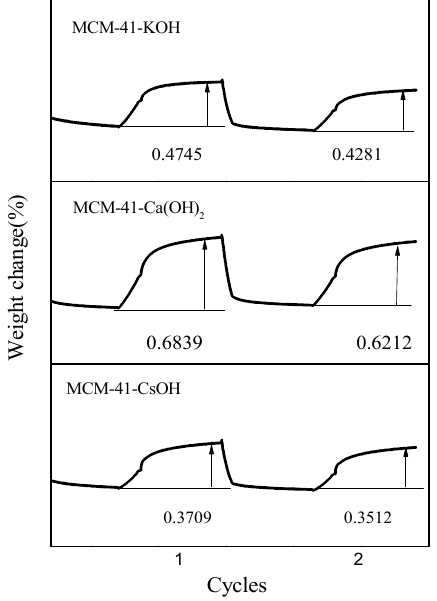
Figure 7. Cycle adsorption/desorption performance of inorganic alkali modified adsorbents.